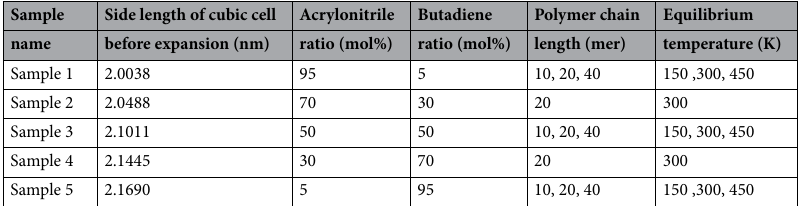
Table 1. Polymer composition and equilibrium temperature conditions.